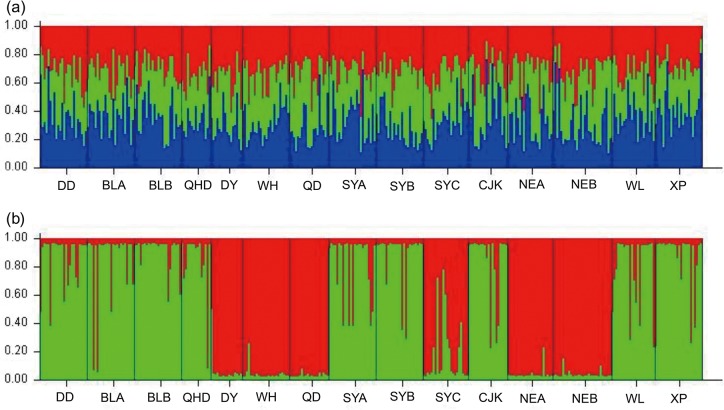
Plotting results of the program STRUCTURE for neutral loci (a) with K = 3, and for locus Lpol03 (b) with K = 2, respectively. Each population is shown as plots and each individual is represented by a single vertical line of different colors, indicating the groups they belong to.